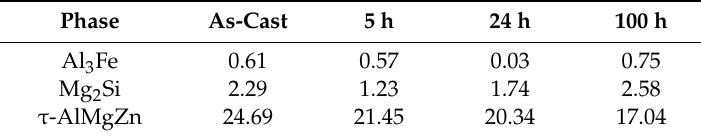
Table 4. Phase quantification of samples of series 2 (% phase).